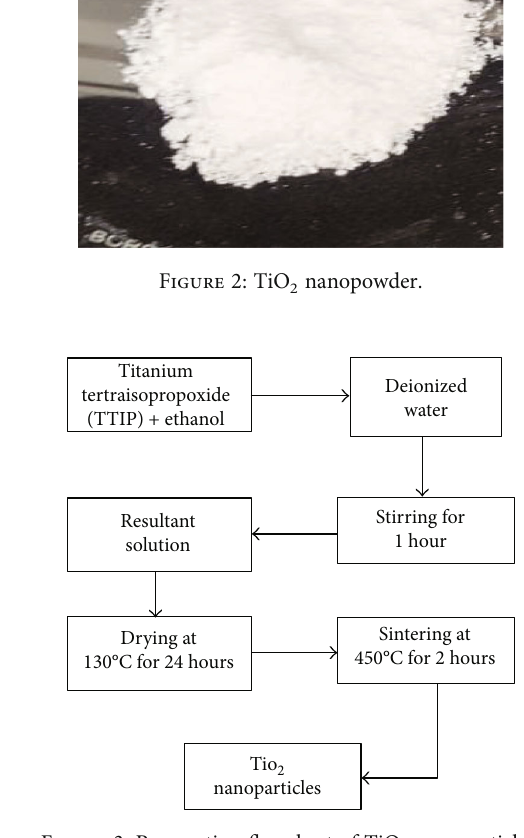
nanoparticles. 2